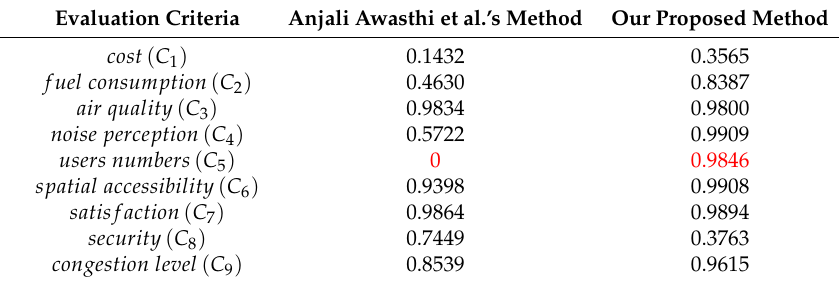
Table 9. Global utilities of testing for nine criteria with two